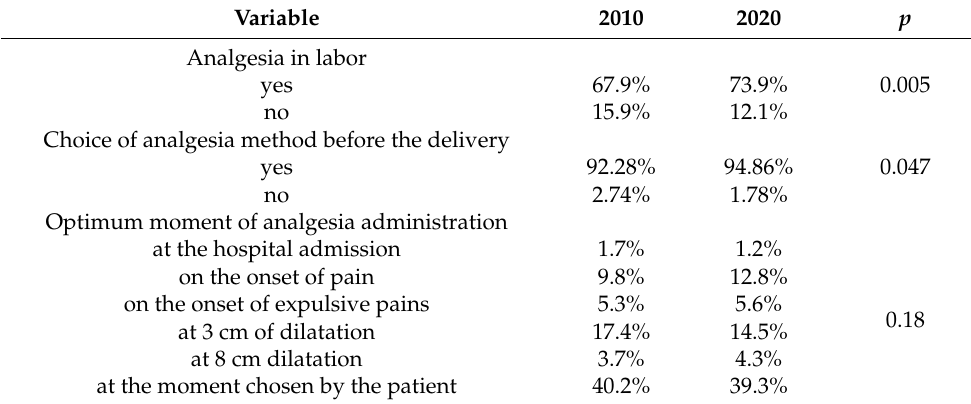
Table 2. Women’s opinions and preference for intrapartum